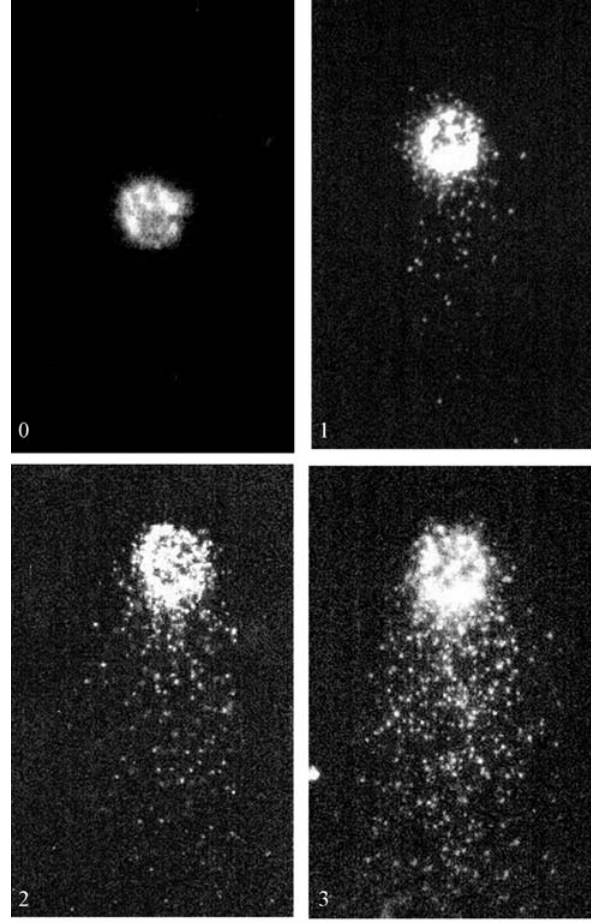
Figure 1 - Hemolymph cells exposed to methylmethane sulfonate (MMS). Class 0: undamaged cells; classes 1, 2 and 3: from the less to more damaged cells.